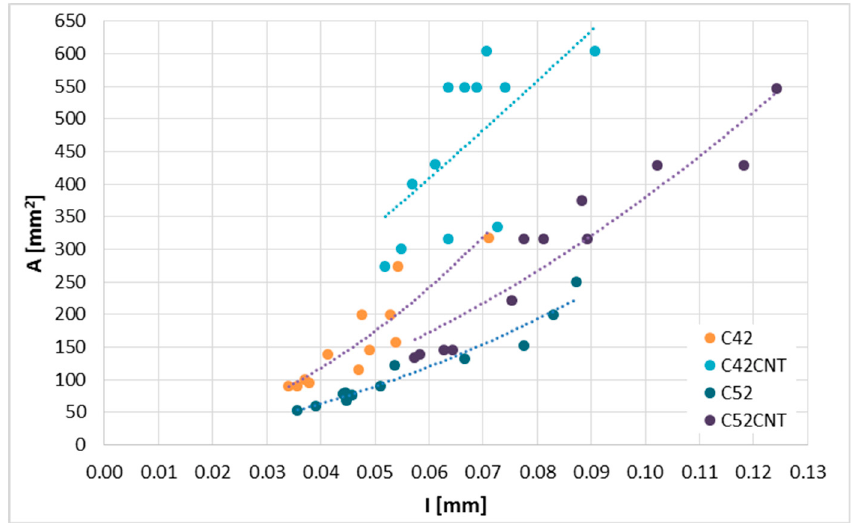
(cid:16) (cid:17) Figure 8. The 𝐴̅(𝐼̅) relationship divided into series. I Figure 8. The A relationship divided into Table 4. Equations of the functional curves describing the 𝐴̅(𝐼̅) relationship divided into series; R 2 , S e , W —diagnostic statistics; ρ —correlation coefficient.